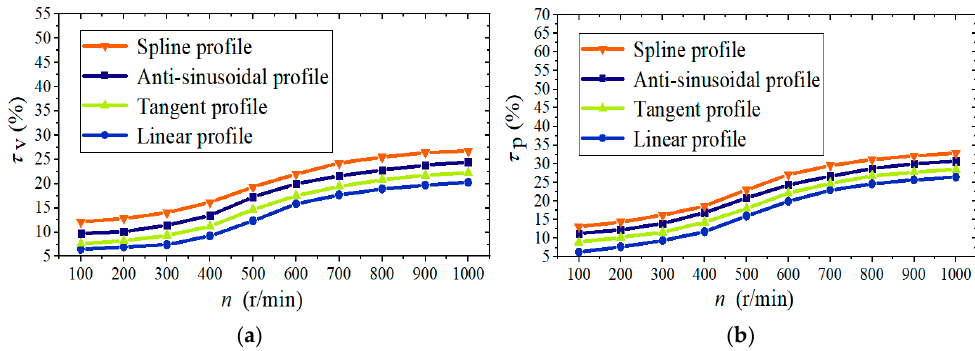
Figure 12. Relationship between cavitation ratio (CR) and rotating speed. ( a ) Valve port CR; ( b ) pump chamber CR.